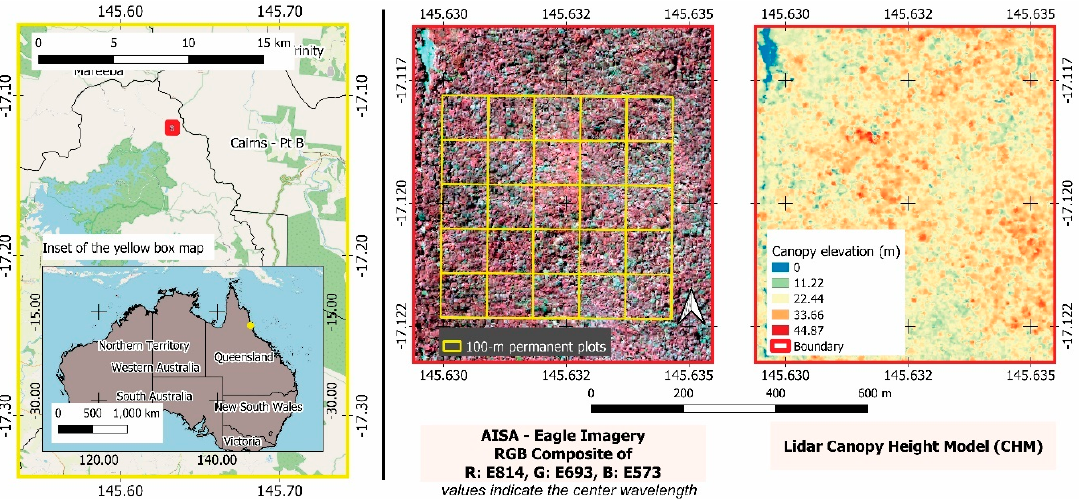
Figure 1. Study site area of Robson Creek, Far North Queensland, Australia, with the ( right figure ) showing the canopy height model from airborne lidar and the middle figure showing the AISA (Airborne Imaging Spectrometer for Applications) false color composites and the 100-m plots, while the ( left figures ) show the inset of the study area over broader scales.